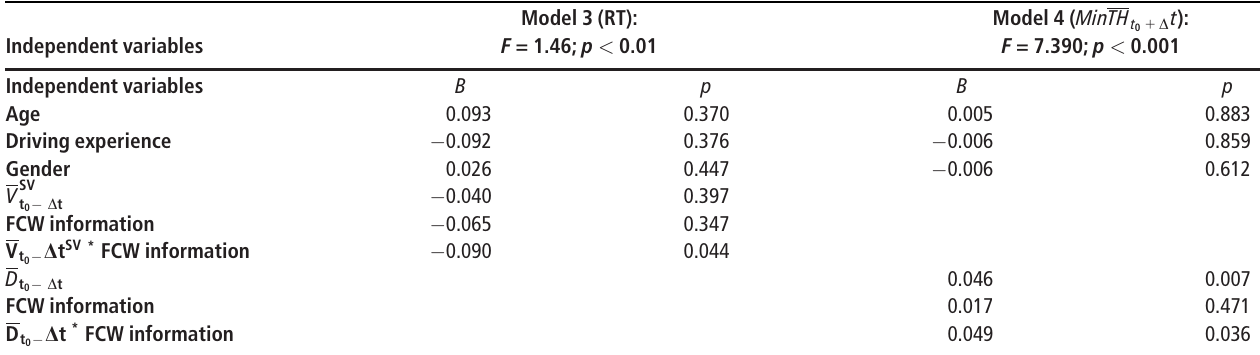
Table 6 Moderating effects of FCW information on RT and MinTH t Independent variables